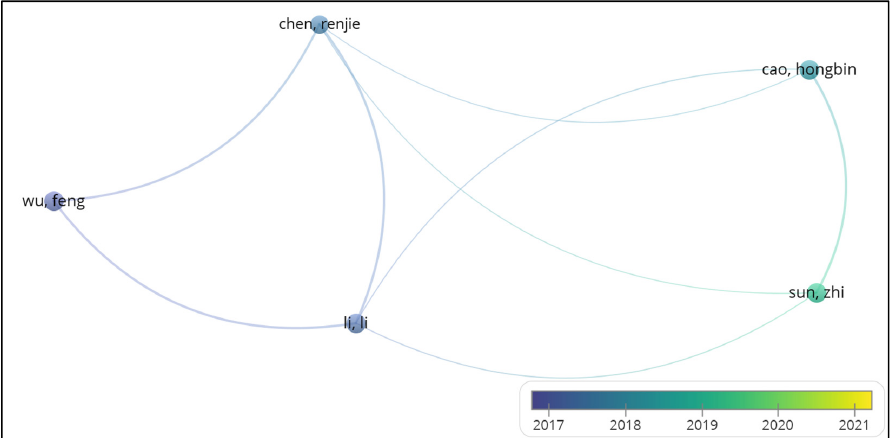
Figure 11. Authors with the greatest number of published articles in the LIB recycling bibliographic portfolio—VOS Viewer Overlay Visualization.